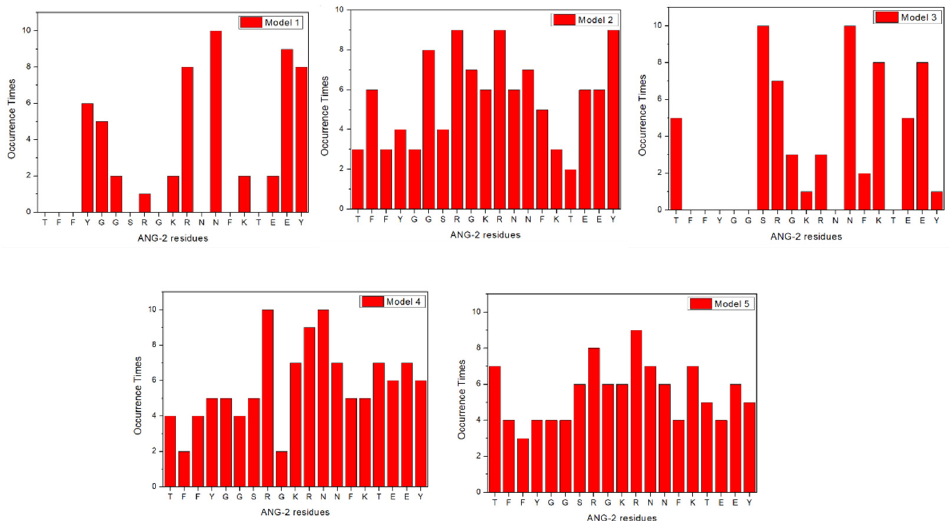
Figure 5. Angiopep-2 residues involved in LRP-1 binding from model 1 to model 5.